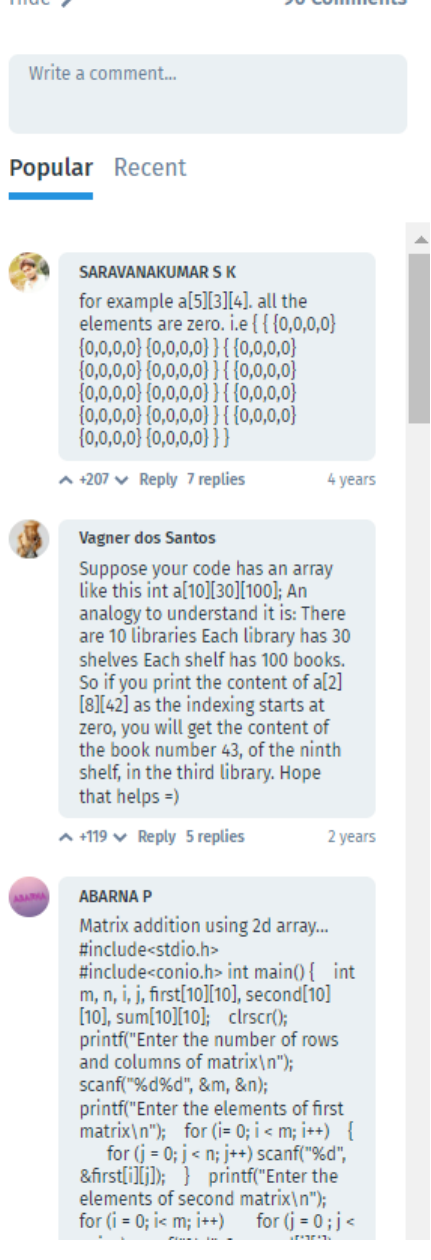
Figure 3: The ability to communicate through comments in the MOOC Sololearn.